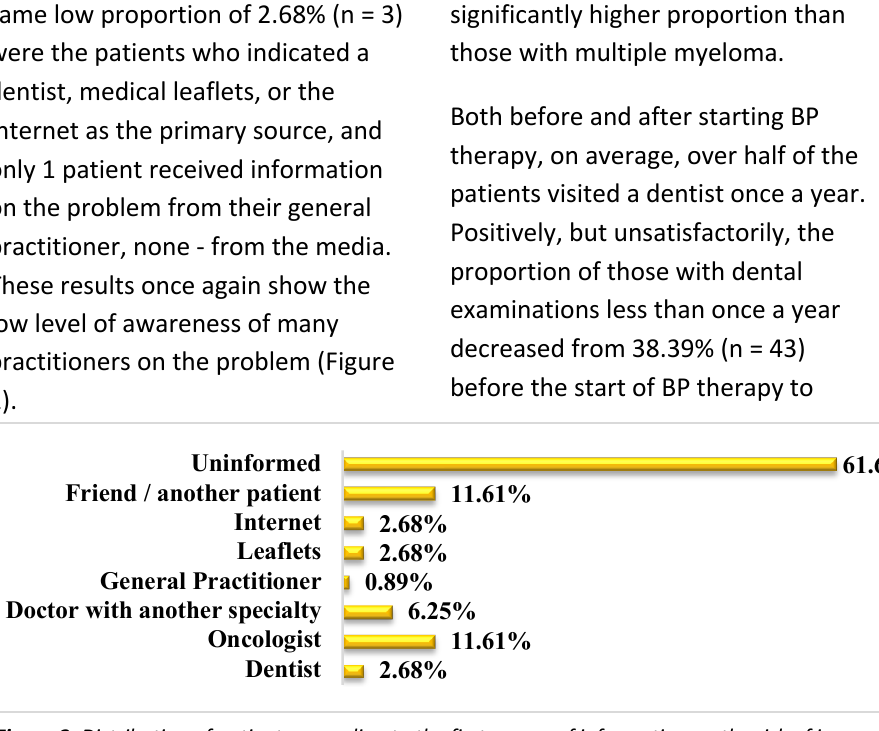
Figure 2. Distribution of patients according to the first source of information on the risk of jaw complications associated with the application of BP.